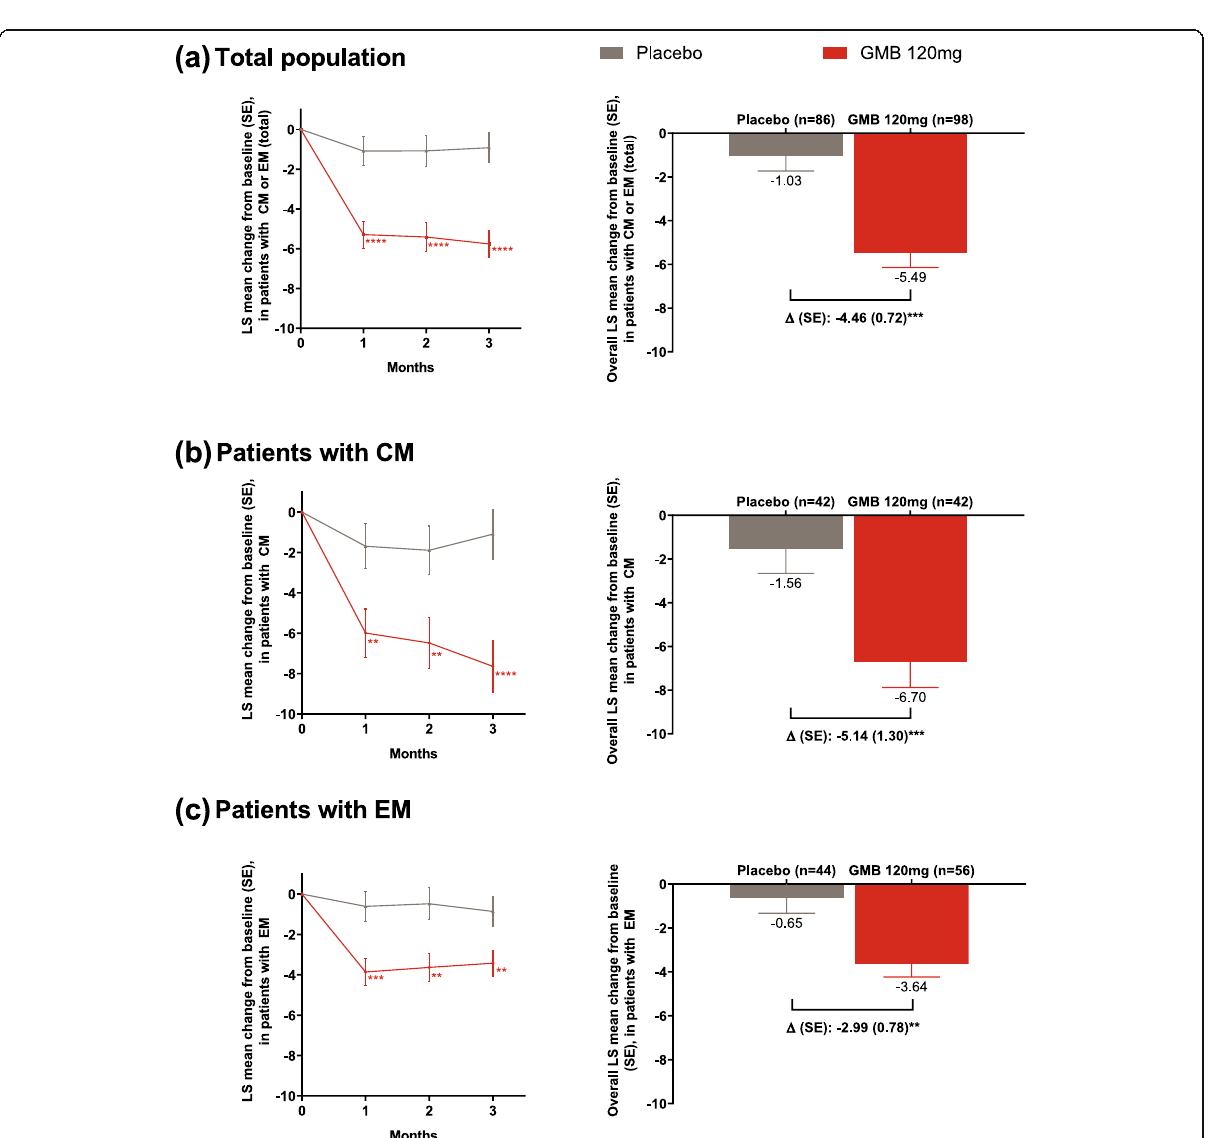
Fig. 1 Monthly and overall least square (LS) mean changes from baseline in the number of migraine headache days during the treatment period in a the total population # , b patients with CM # and c patients with EM # . # Patients who had failed 3 – 4 preventive medication categories due to inadequate efficacy (after at least 2 months at maximum tolerated dose), or safety or tolerability reasons within the last 10 years. **** P ≤ .0001, *** P ≤ .001, ** P ≤ .01 versus placebo. Abbreviations: CM, chronic migraine; EM, episodic migraine; GMB, galcanezumab; n, number of patients with non-missing baseline value and at least one post-baseline value; SE, standard placebo (17.4% versus 3.6%; OR [95% CI], P: 5.6 [1.9, 16.1]; P ≤ 0.010).